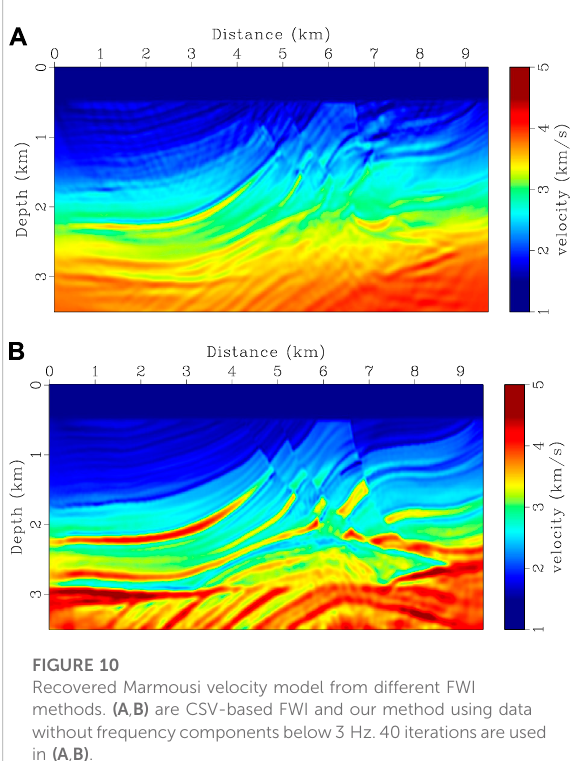
FIGURE 10 Recovered Marmousi velocity model from different FWI methods. (A , B) are CSV-based FWI and our method using data withoutfrequencycomponentsbelow3 Hz.40iterationsareused in (A , B)